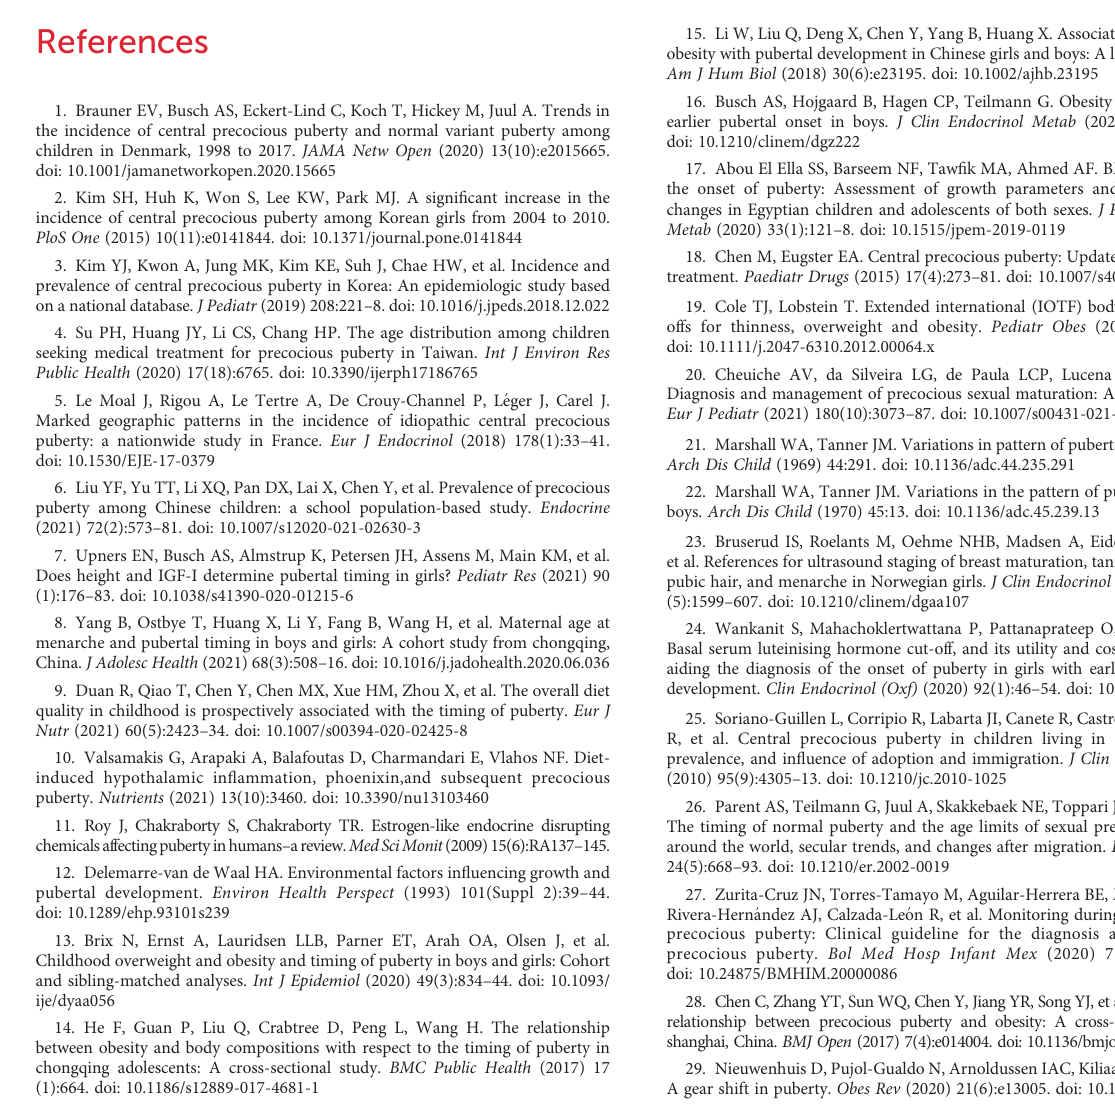
SUPPLEMENTARY TABLE 2 The number of obese girls with basal LH ≥